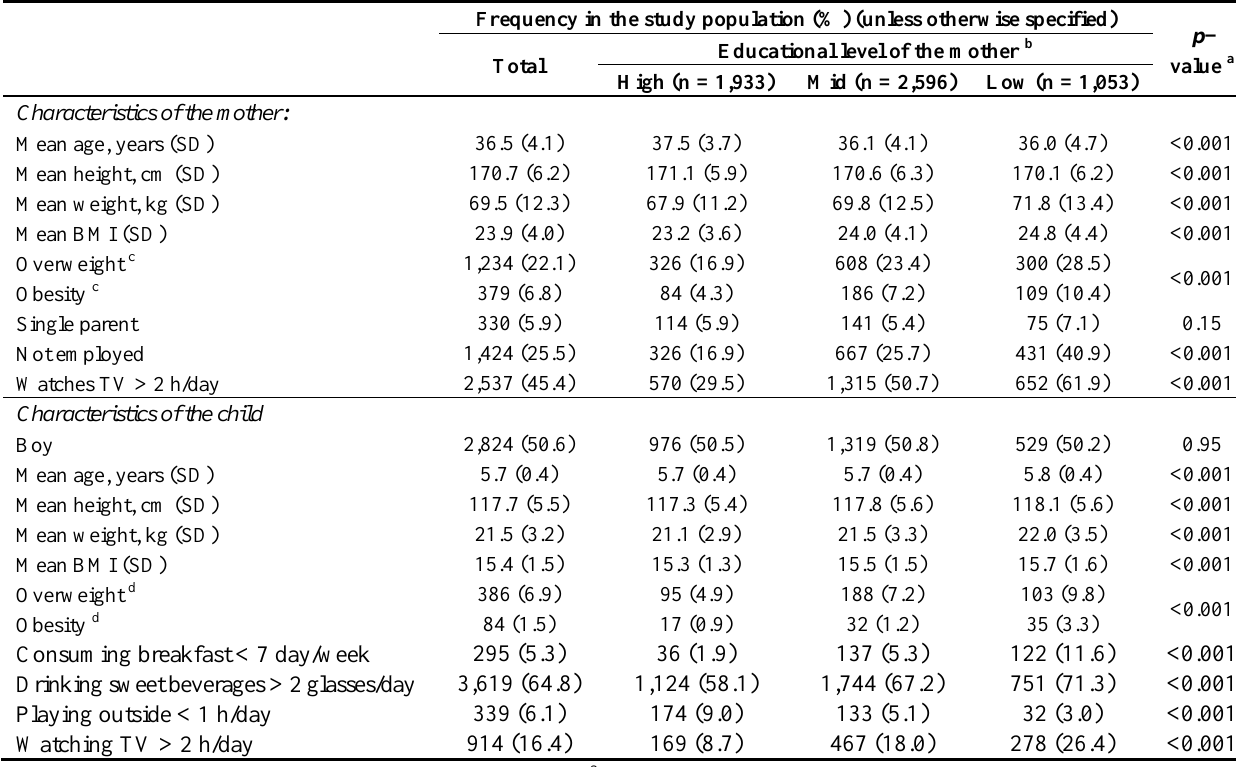
Table 1. Characteristics of the total study population (n = 5,582), and by educational level of the mother. Frequency in the study population (%) (unless otherwise specified)